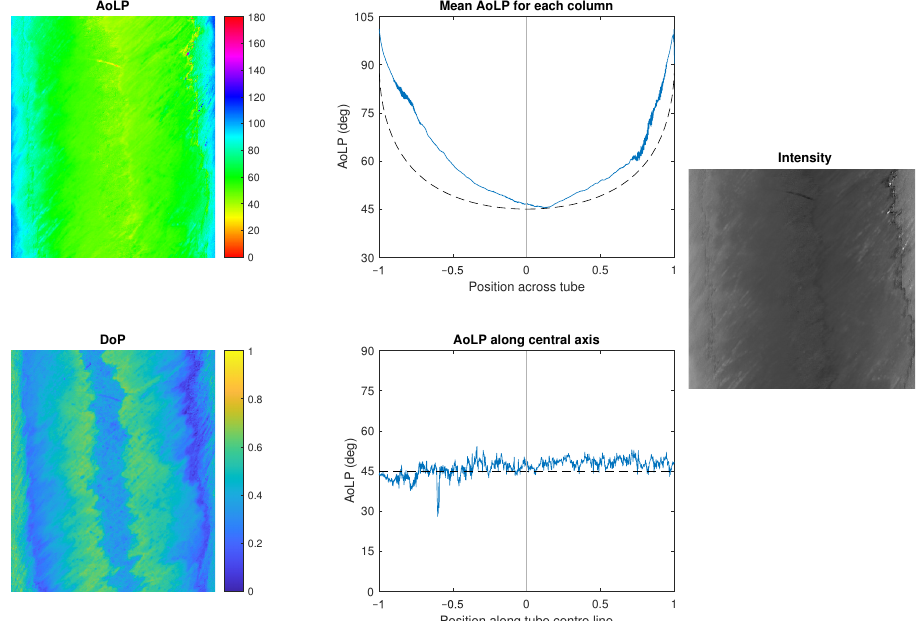
Figure 26. Recovered data for the UD dry tube under dark field illumination in a similar format to the case of Figure